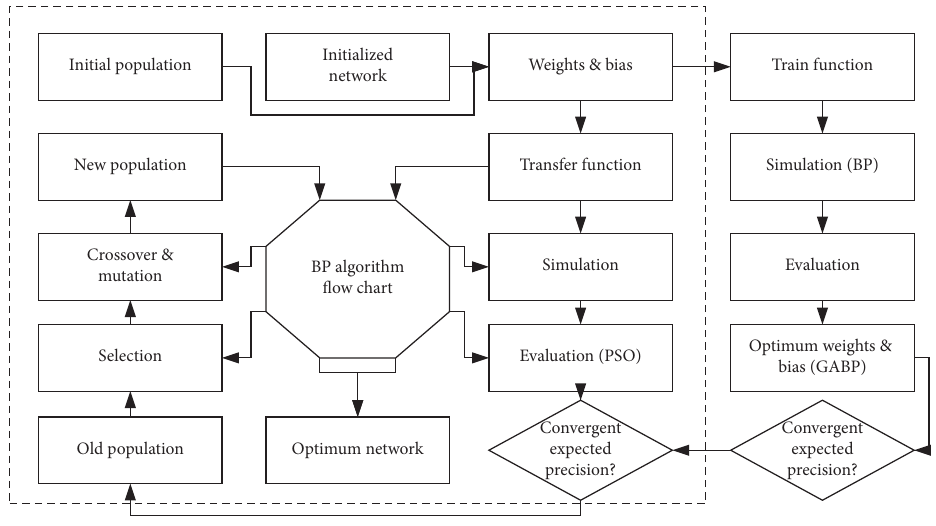
Figure 2: BP algorithm flow Table 1: Principal component variables corresponding to the 7 nodes in the input layer.